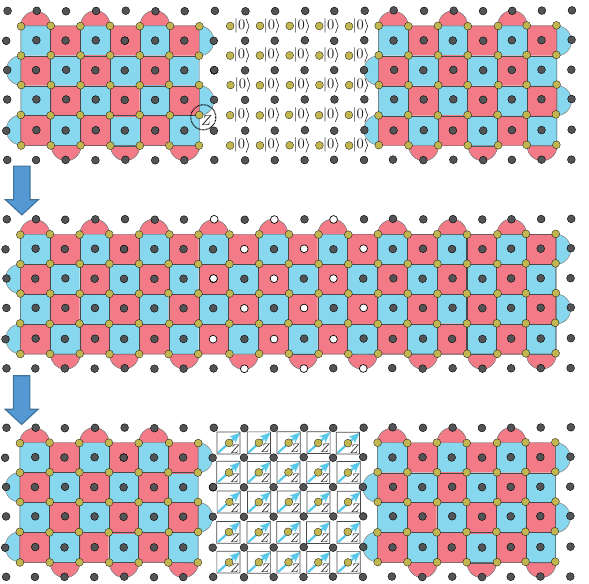
FIG. 4. An example of an X ⊗ X measurement performed on two d x = 5, d z = 7 logical patches. Data qubits in the routing space are first prepared in the | 0 (cid:3) state. In the first round of stabilizer measurements, where the logical patches are merged